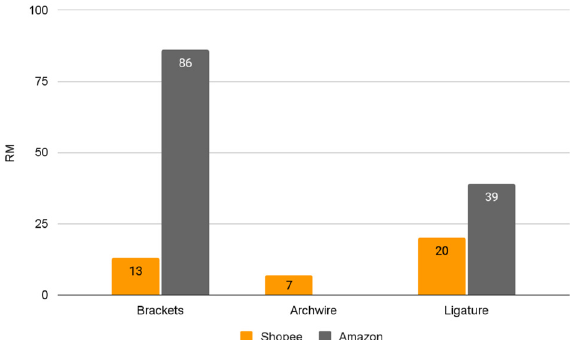
Figure 4. Average price (RM) of orthodontic products on Amazon and Shopee.